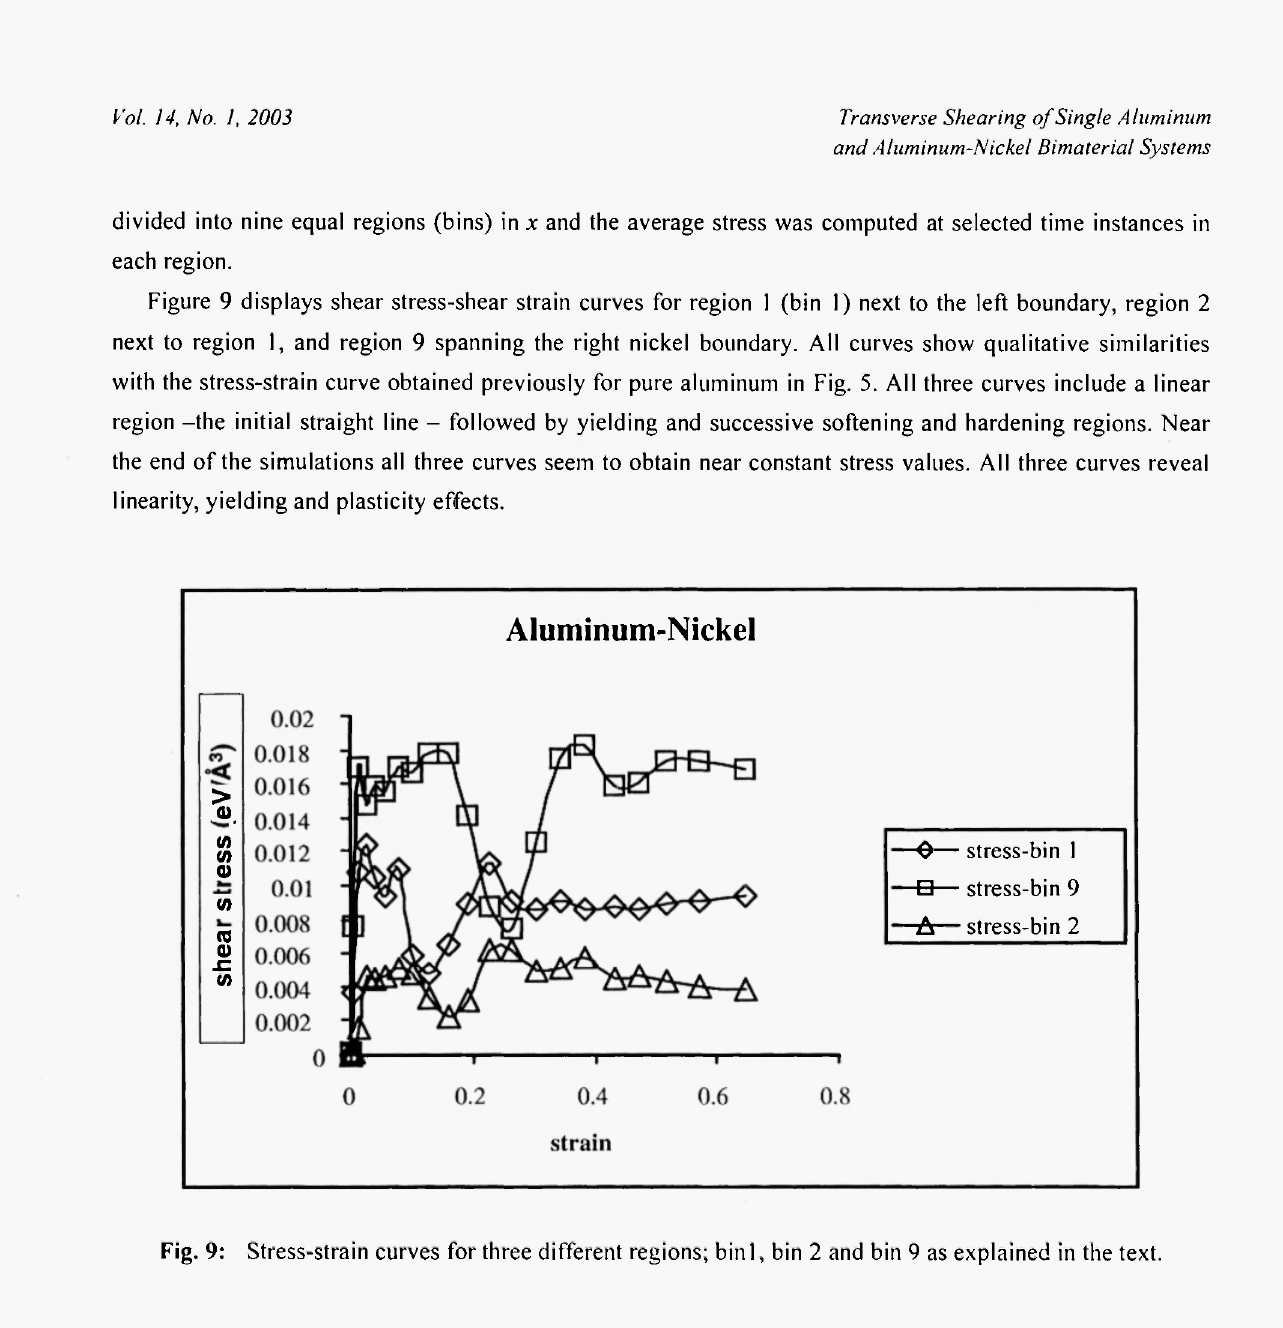
Fig. 9: Stress-strain curves for three different regions; bin 1, bin 2 and bin 9 as explained in the